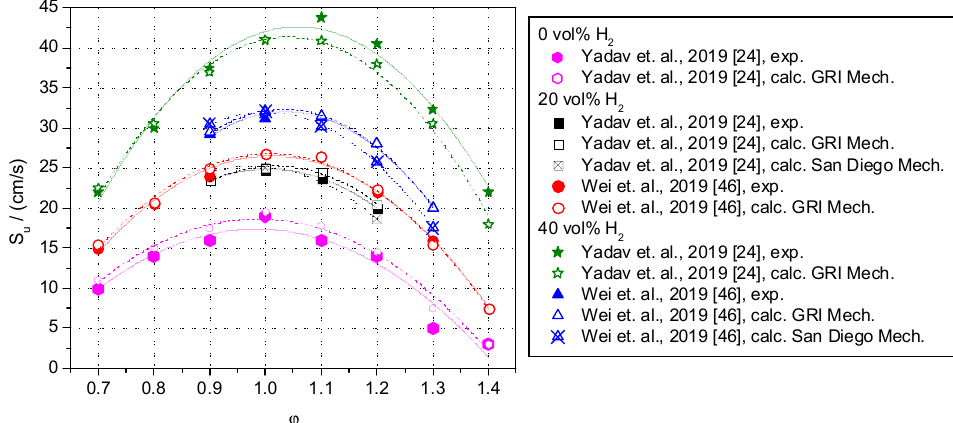
Figure 13. Variation of the laminar burning velocities of H 2 -enriched biogas mixtures at various equivalence ratios and standard initial conditions; Biogas composition: 50% CH 4 –50% CO 2 .